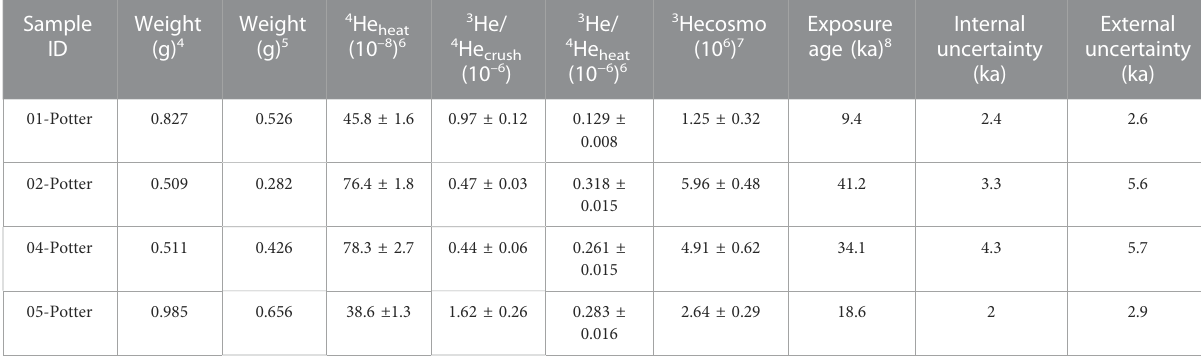
TABLE 4 Results of helium measurements at GFZ Potsdam in pyroxene separates from the Three Brothers Hill samples. 4 He concentrations are in units of cm 3 STP g − 1 , 3 He concentrations in atoms g − 1 ; all error limits are 2 σ . Erosion rate of 0 and rock density of 2.7 g cm − 3 were assumed.